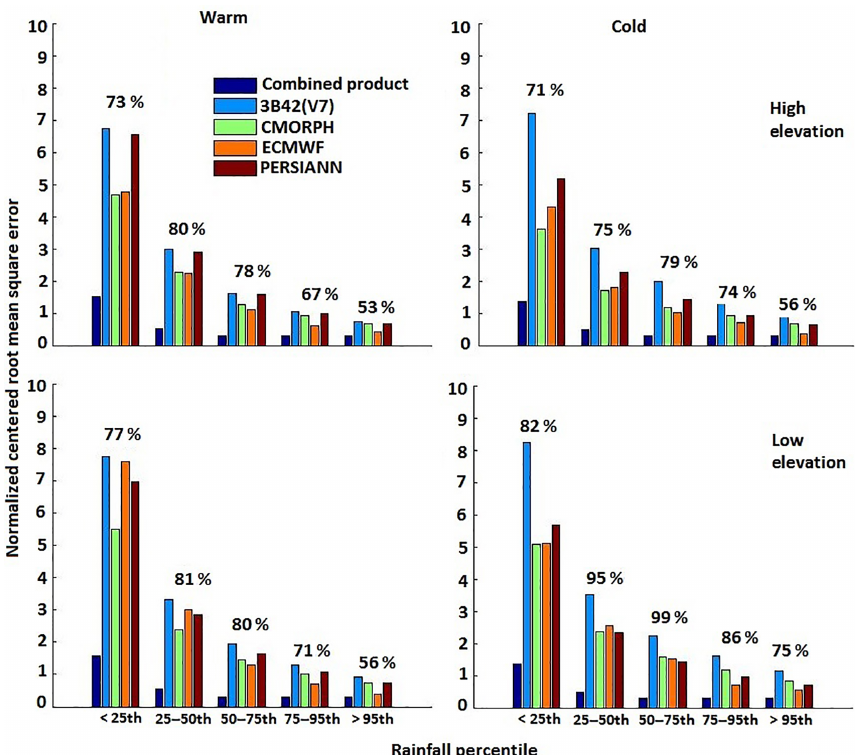
Figure 6. Normalized centered root mean square error for warm and cold seasons. The relative error reductions for the combined product (relative to other products) are shown above the